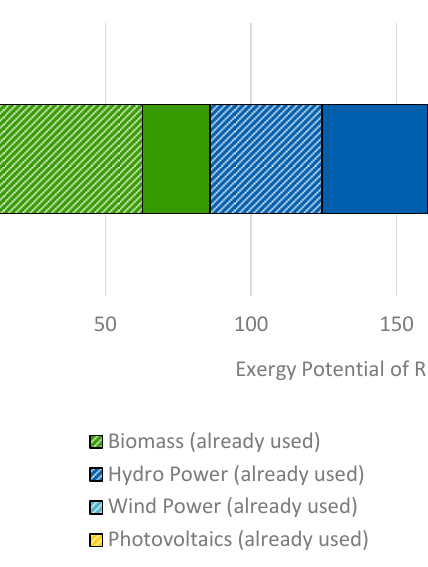
Figure 16. Comparison of the already used and the currently unused potential of RES in Austria. Currently there are only 109 of 266 TWh / a used. One can see that there is a lot of unused potential of wind power and photovoltaics (Source already used renewables in 2017: [2]).